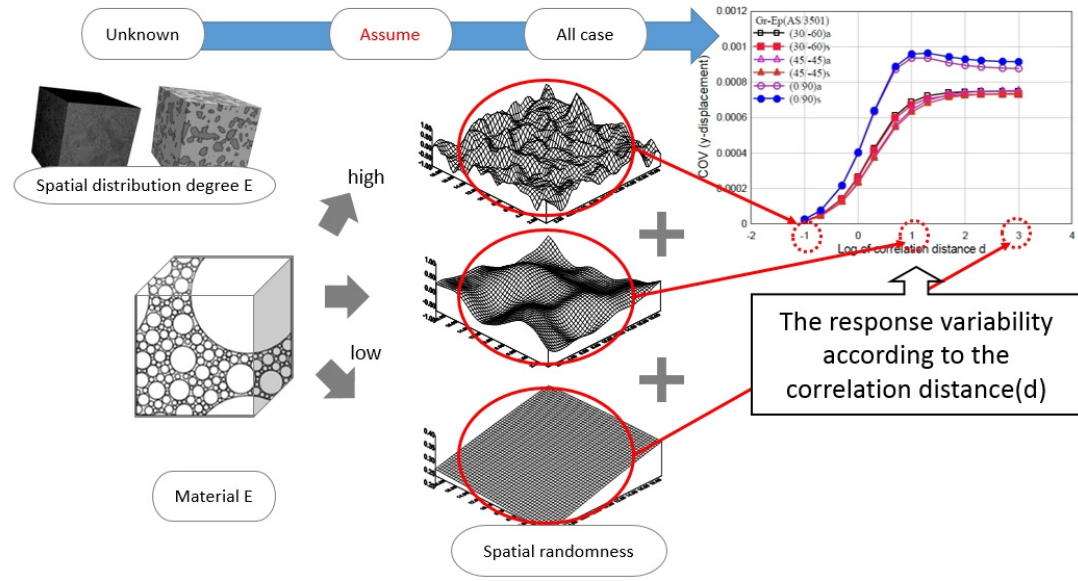
Figure 2. The schematic of the response variability according to the correlation distance (d).